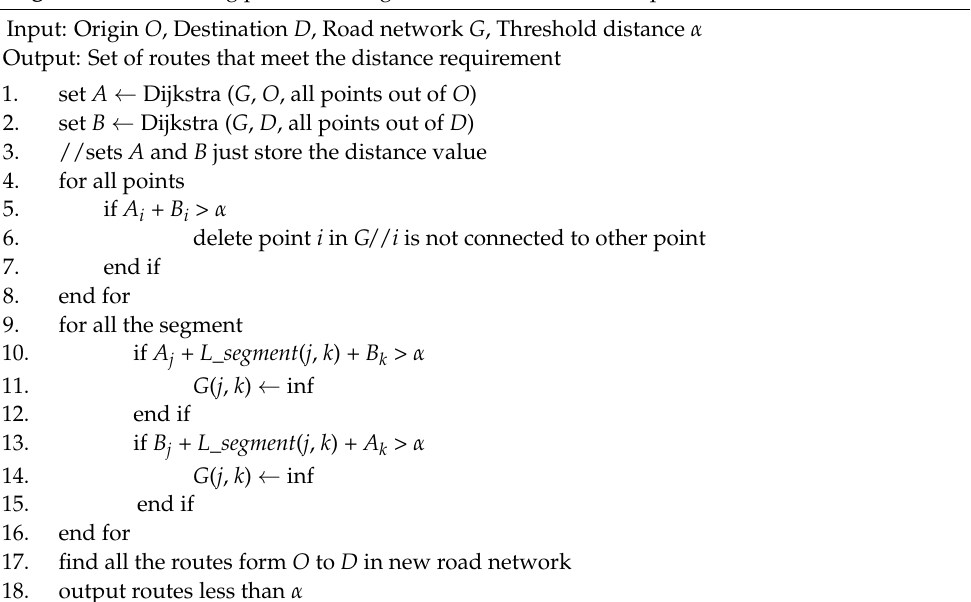
Algorithm 1 Removing points and edges that fail the distance